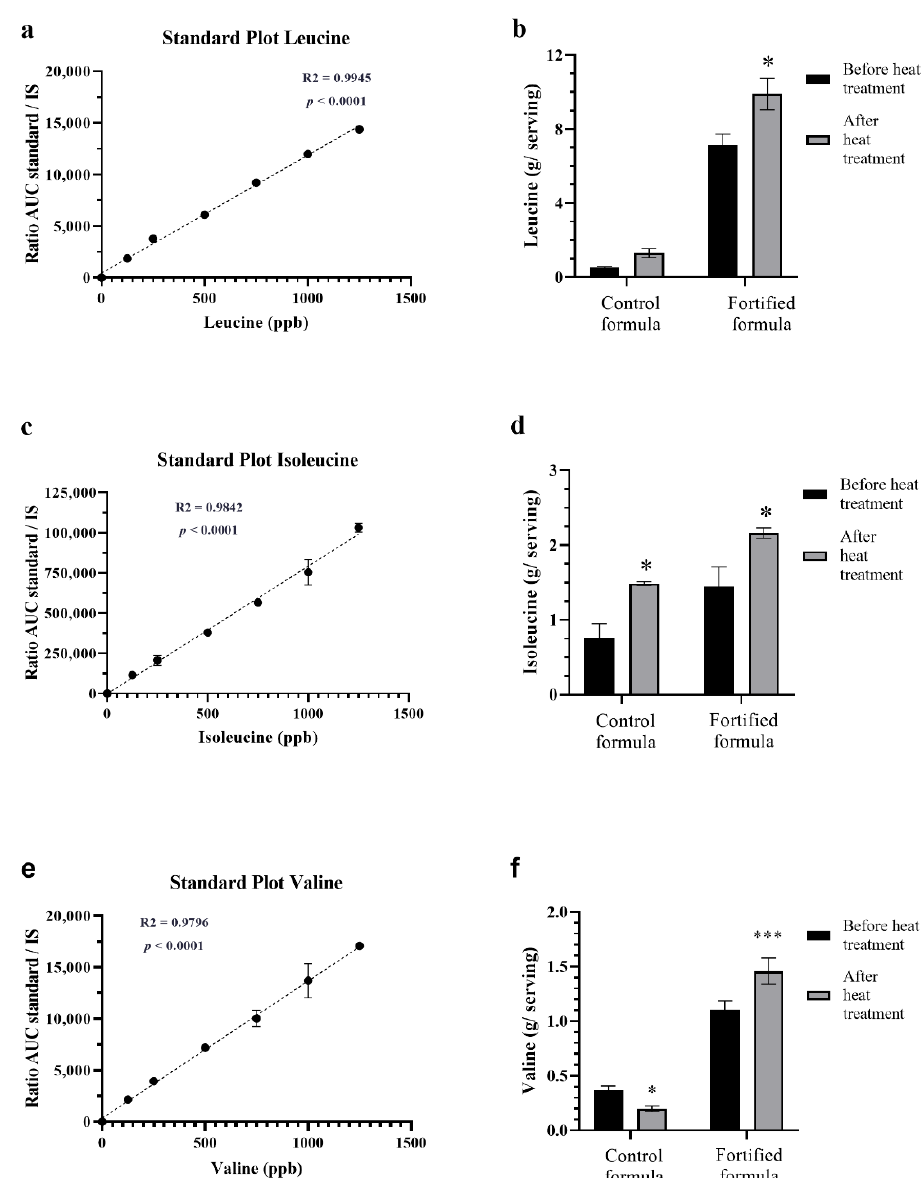
Figure 3. Effect of retort sterilization on the amount of branch-chain amino acids in control and fortified formulas. Standard curves of leucine ( a ), isoleucine ( c ), and valine ( e ), obtained from the ratio of area under the curve (AUC) between respective standards and internal standards and the concentrations of each amino acid, analyzed by LC-MS/ MS. R 2 and p-values were obtained by using linear regressions. Bar graphs show the amounts of leucine ( b ), isoleucine ( d ), and valine ( f ) in the control and fortified formulas before and after retort processing. * and *** mean p < 0.05 and 0.001, comparing before and after retort using paired t-tests.